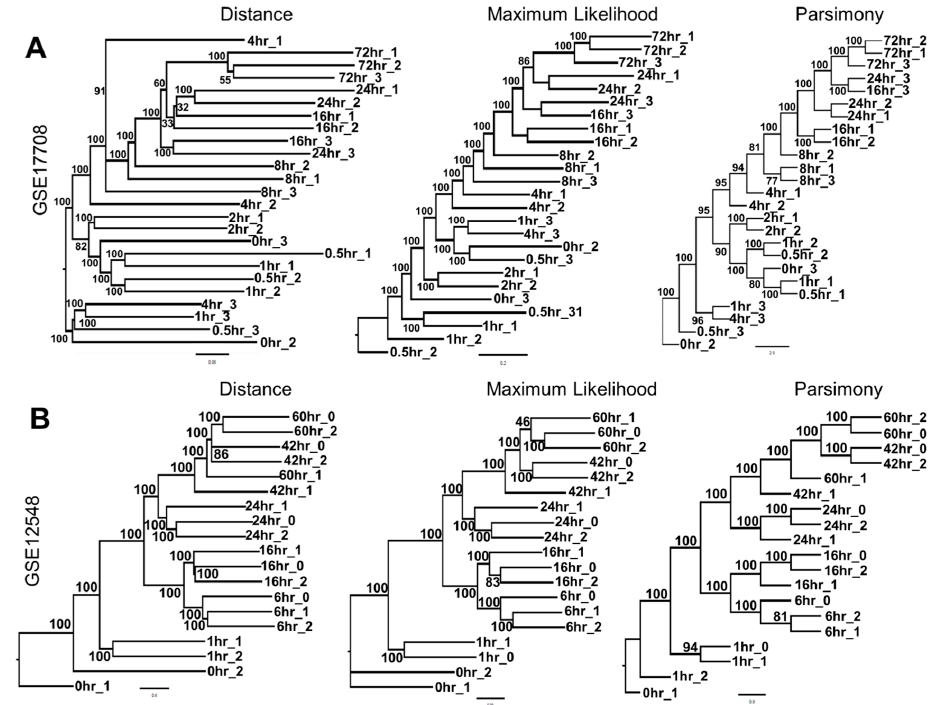
3 Figure 3. Phylogenetic clustering enables reconstruction of longitudinal data based on gene expression. ( A ) Distance, maximum parsimony, and maximum-likelihood dendograms of GSE17708; microarray analysis of A549 cells treated with TGF- β over 72 h. ( B ) Distance, maximum parsimony, and maximum-likelihood phylogeny construction of GSE12548; TGF- β and TNF- α treatment of human retinal pigment epithelium cells over 60